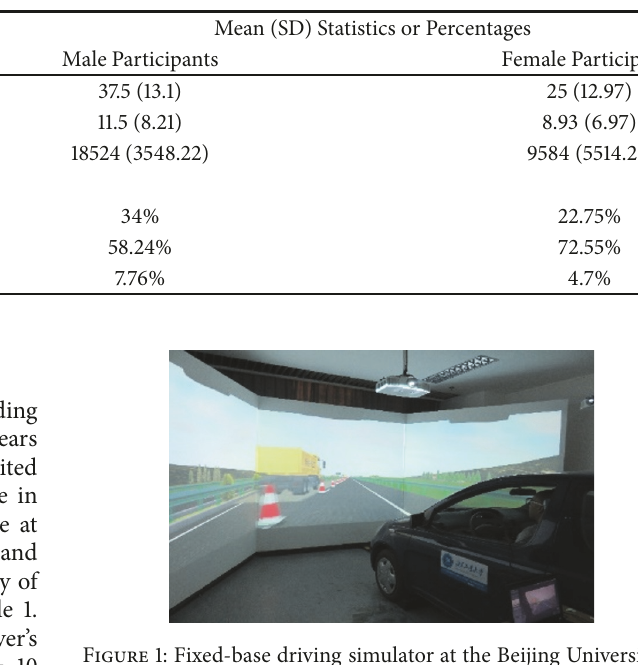
Table 1: Demographics summary.